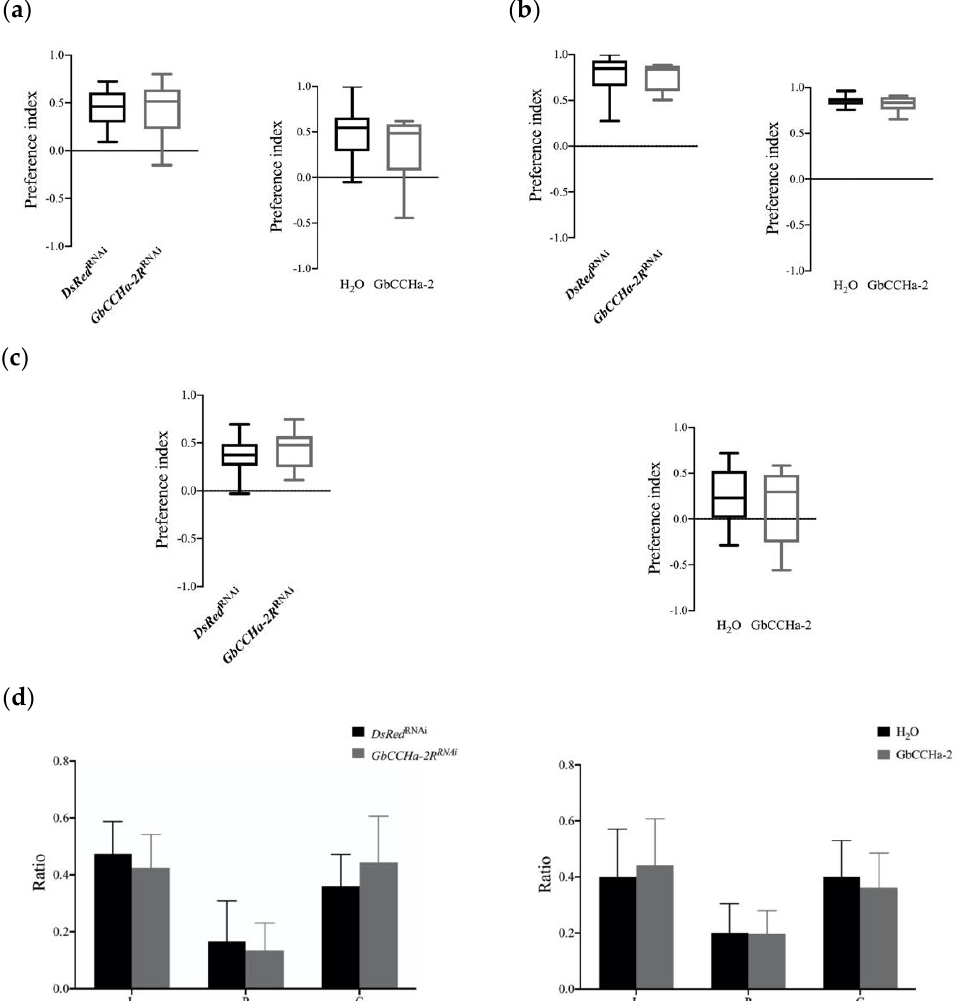
Figure 6. Effects of GbCCHa-2 signaling on food choices: ( a – c ) Effects of GbCCHa-2R knockdown and peptide injection on the evaluation of the contents of lipids ( a ), carbohydrates ( b ), and proteins ( c ) in diets. Preference index = [W (rich nutrient) − W (poor nutrient) ]/[W (rich nutrient) + W (poor nutrient) ]. W, weight of diet eaten; ( d ) Effects of GbCCHa-2R knockdown and GbCCHa-2 application on the differentiation of three macronutrient types. Ratio = W (one nutrient) /W (total) . Values are shown as mean ± S.D., n = 7 – 11, unpaired t -test.